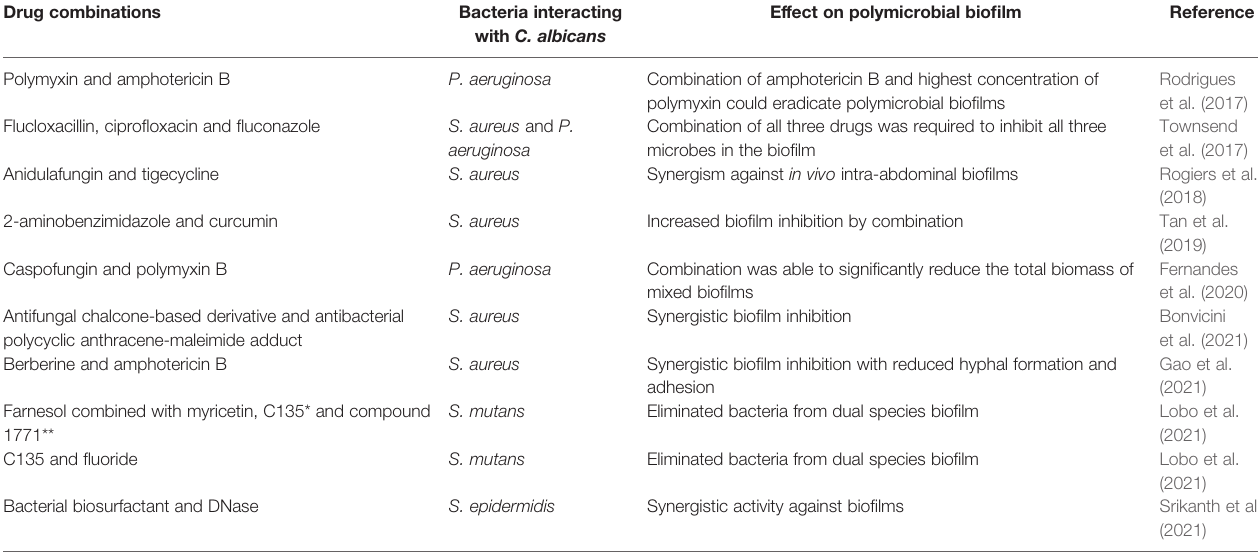
TABLE 5 | Combination therapy against polymicrobial bio fi